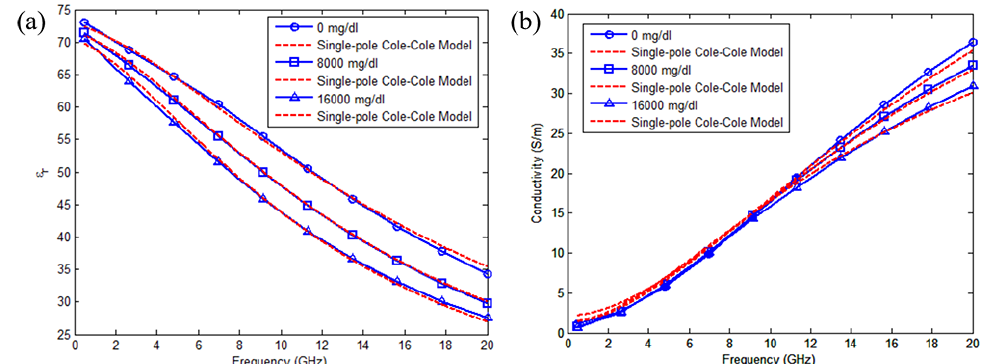
Figure 4. ( a ) Dielectric constant and ( b ) conductivity values obtained form measured data and corresponding fitted models at three differential glucose levels in the 0.5–20 GHz band (Reprinted with permission from [44]; published by IEEE, Toulouse, France,